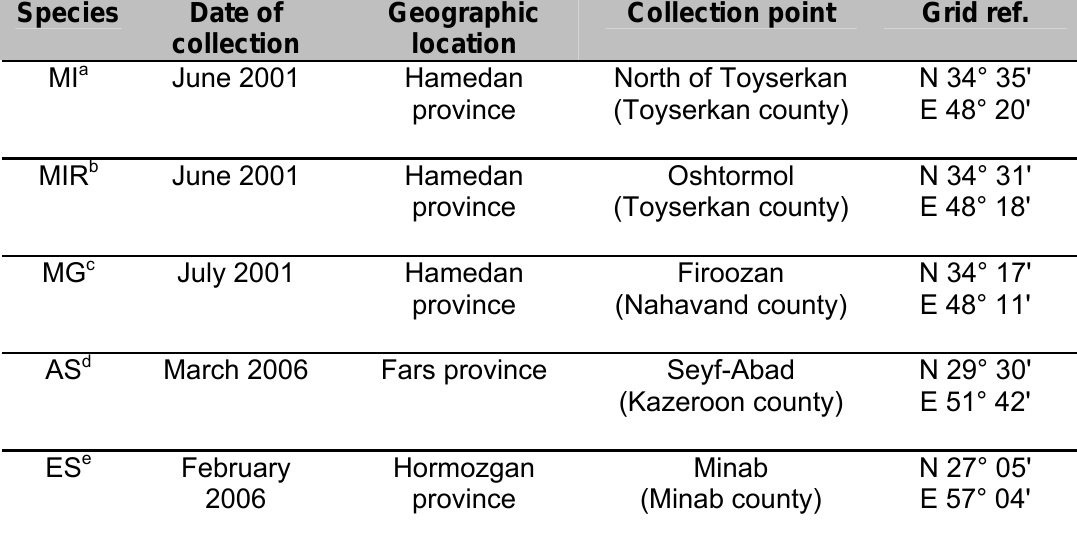
Table 3. Blister beetles (Coleoptera: Meloidae) in Iran: faunal diversity and collection localities of reported dermal lesions